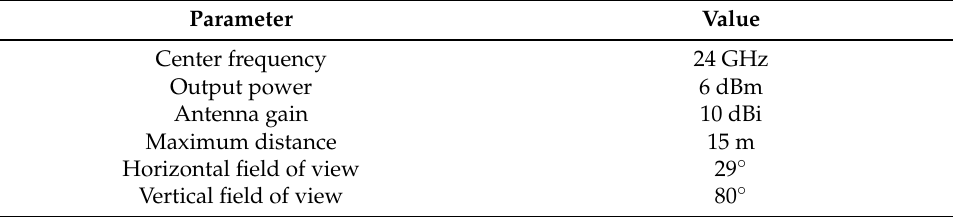
Table 2. Radar sensor